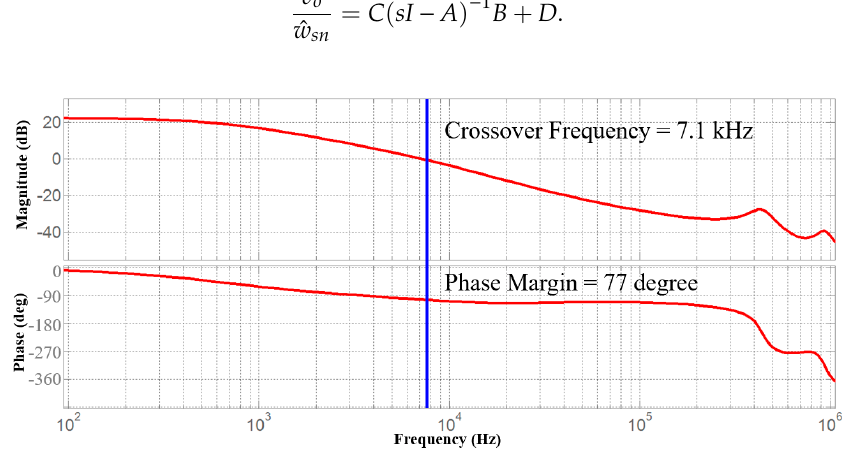
Figure 14. Bode plot of the small signal model of the LLC resonant converter.